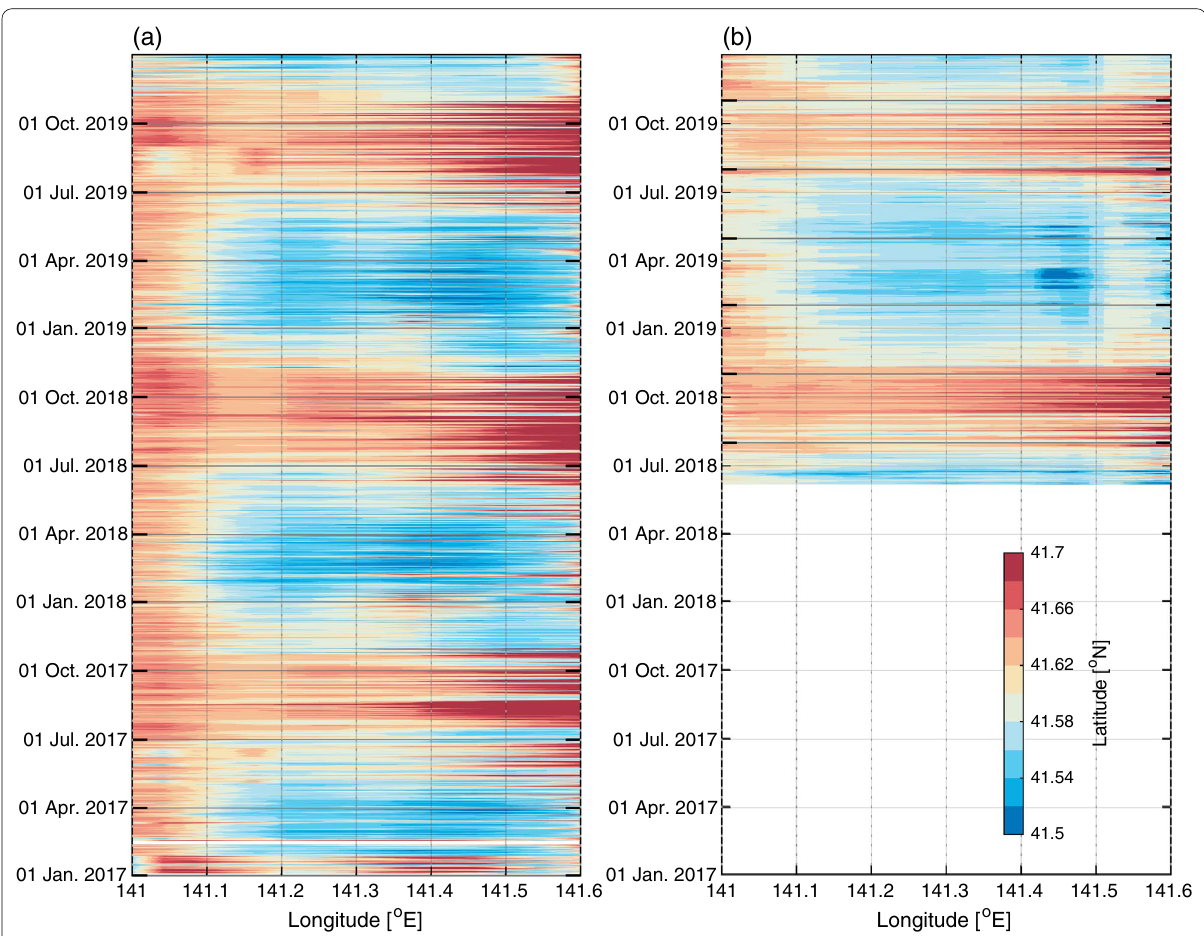
Fig. 6 Longitude–time plot of the axis latitude of the Tsugaru Warm Current estimated from a the high-frequency radar data and b the JCOPE-T DA data at